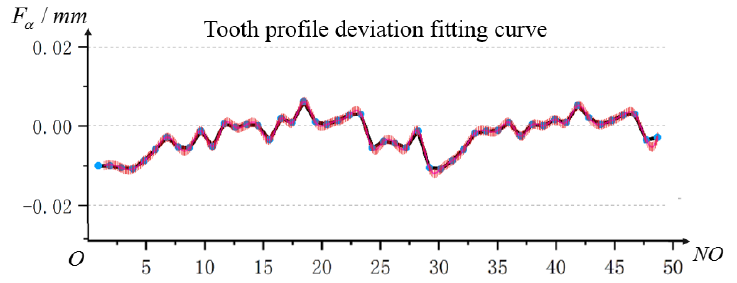
Figure 12. Profile deviation curve.